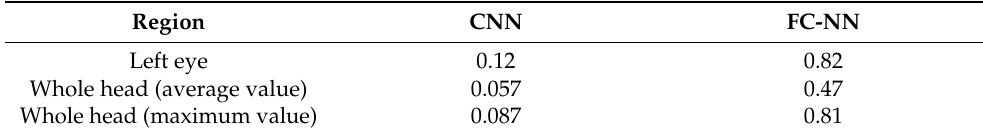
Table 2. Comparison between CNN and FC-NN in terms of RMSE. Region CNN FC-NN Left eye 0.12 0.82 Whole head (average value) 0.057 0.47 Whole head (maximum value) 0.087 0.81